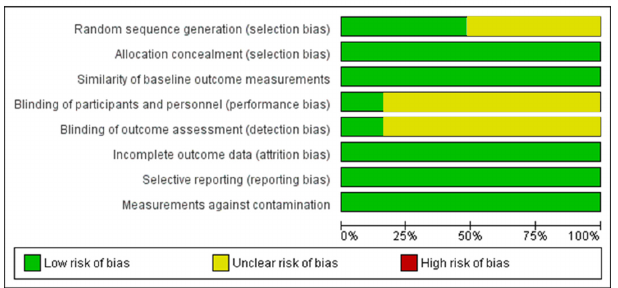
Figure 6. Graph of the risk of bias assessment of the included studies. Int. J. Environ. Res. Public Health 2021 , 18 , x FOR PEER REVIEW